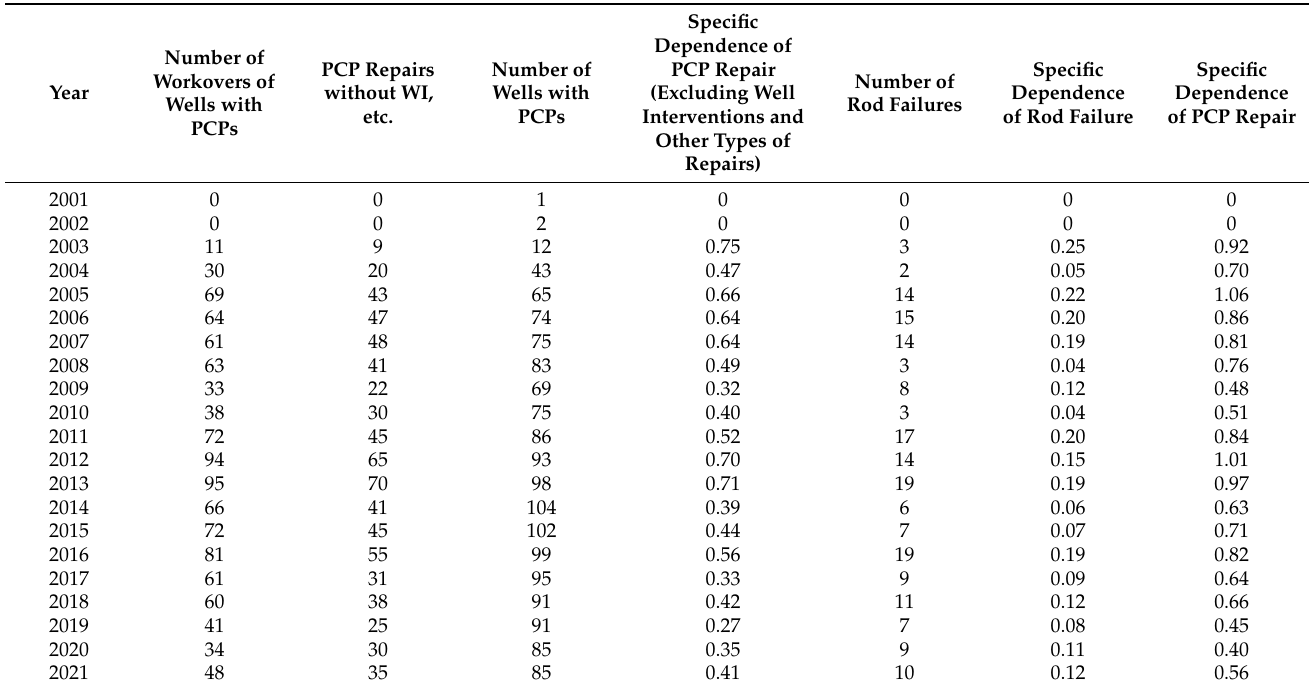
Table 2. Distribution of PCP unit repair by year.